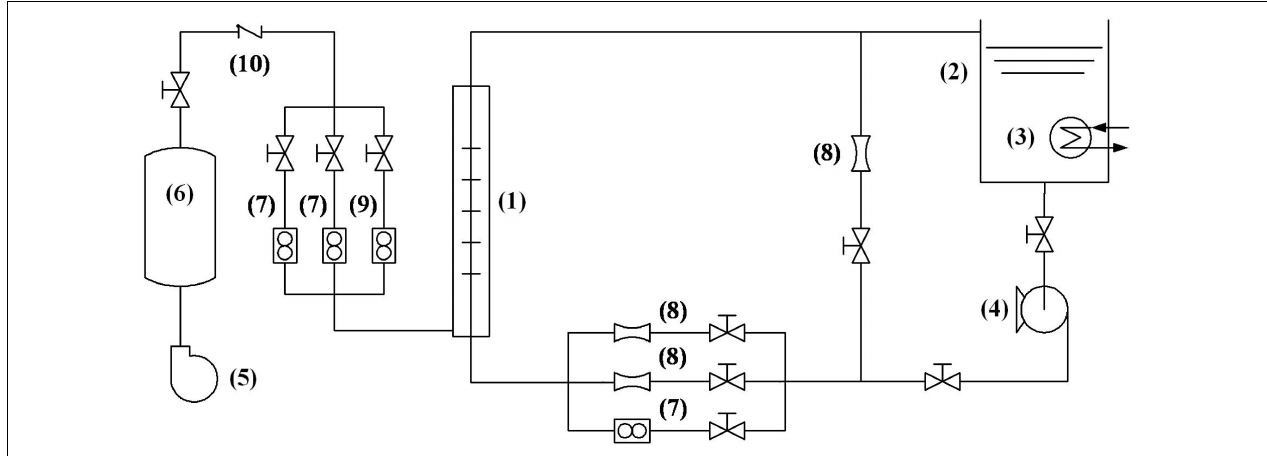
FIGURE 2 | Scheme of the experiment set-up. (1) test section, (2) water tank, (3) heat exchanger, (4) pump, (5) air compressor, (6) air storage tank, (7) Coriolis meter, (8) Venturi meter, (9) Thermal meter, (10) check valve.